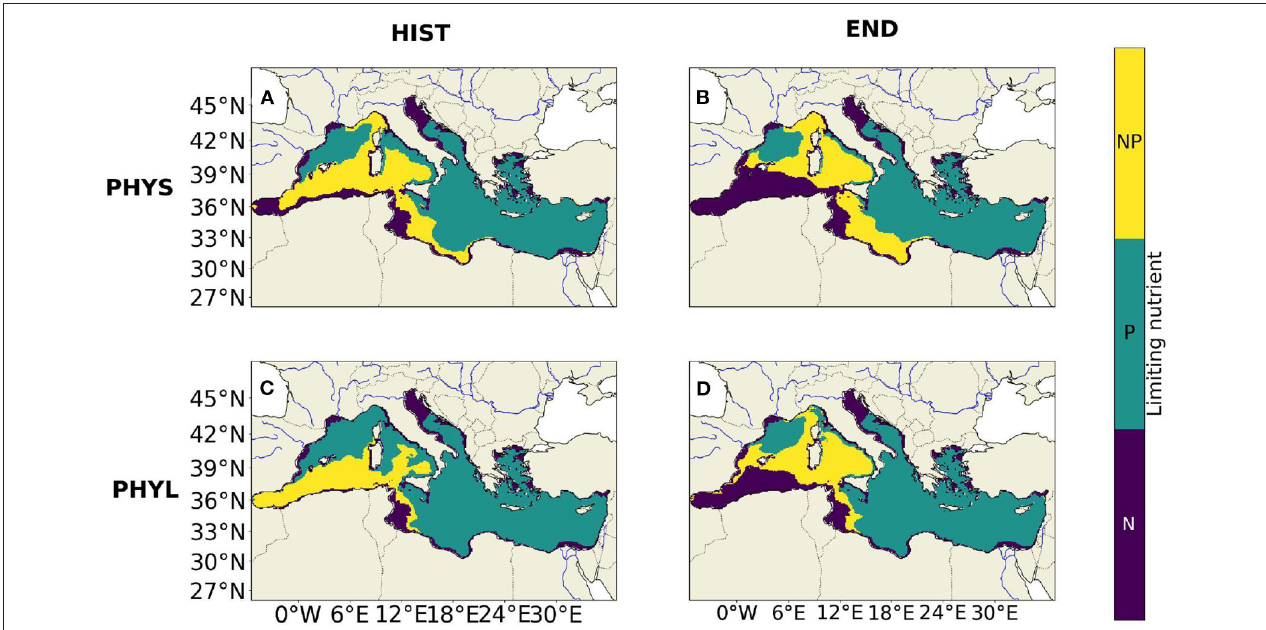
FIGURE 7 | Map of the limiting nutrients over the 0–150 m layer during summer (July to September) for the 1986–2005 period (A,C) and the 2081–2100 period (B,D) . (A,B) for PHYS and (C,D) for PHYL. The areas colored in purple are N limited, the green areas are P limited and the yellow areas are co-limited by N and P (meaning that the difference between N and P normalized cell quotas is <